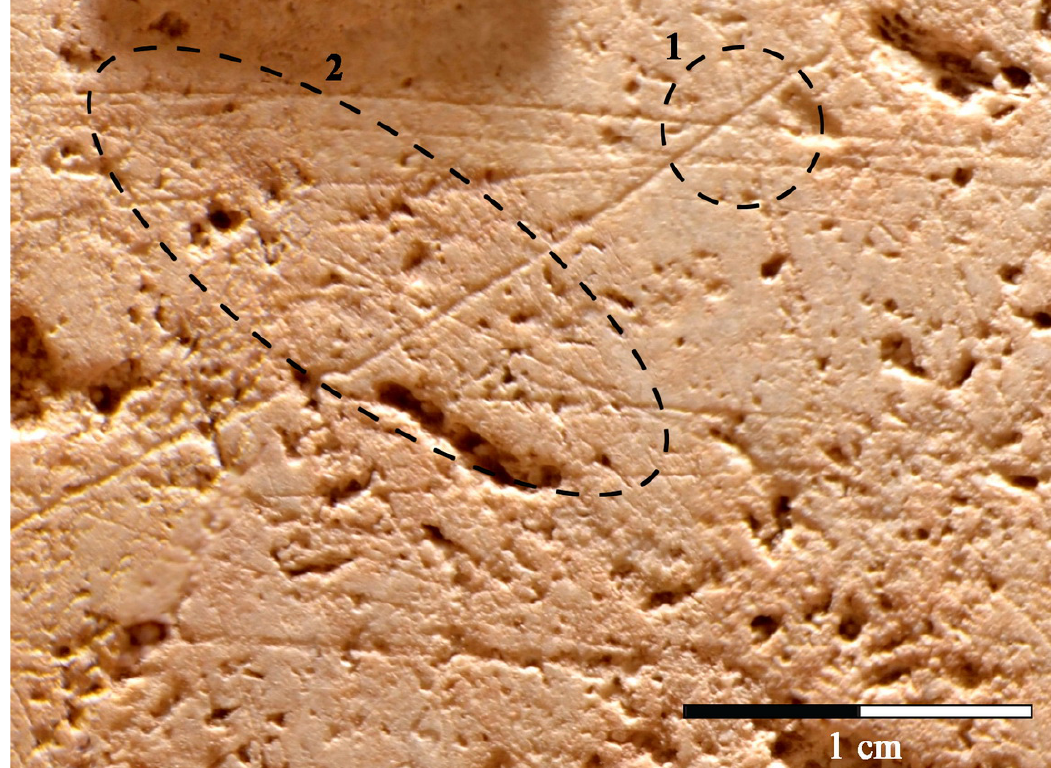
Figure 13. A view of a preserved section with incisions. Note the diagonal line crossing earlier lines (1), and the cluster of light diagonal lines (2), (photograph by E. Crater